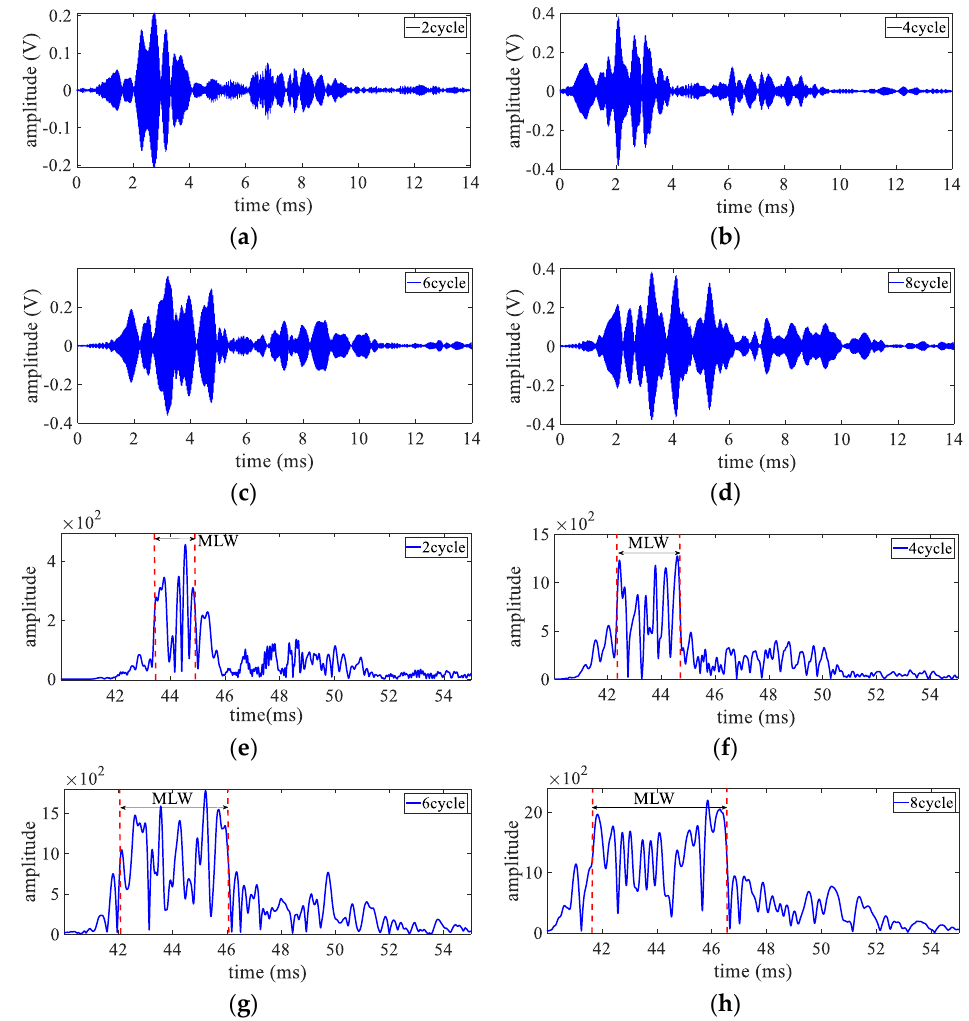
Figure 7. Results analysis of encoding excitation by 15 − bit Kasami sequence under different carrier cycles, ( a – d ) the corresponding received signals, ( e – h ) the decoding results.